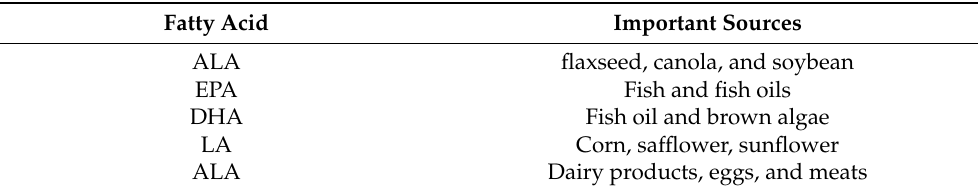
Table 1. Important Sources of n-3 and n-6